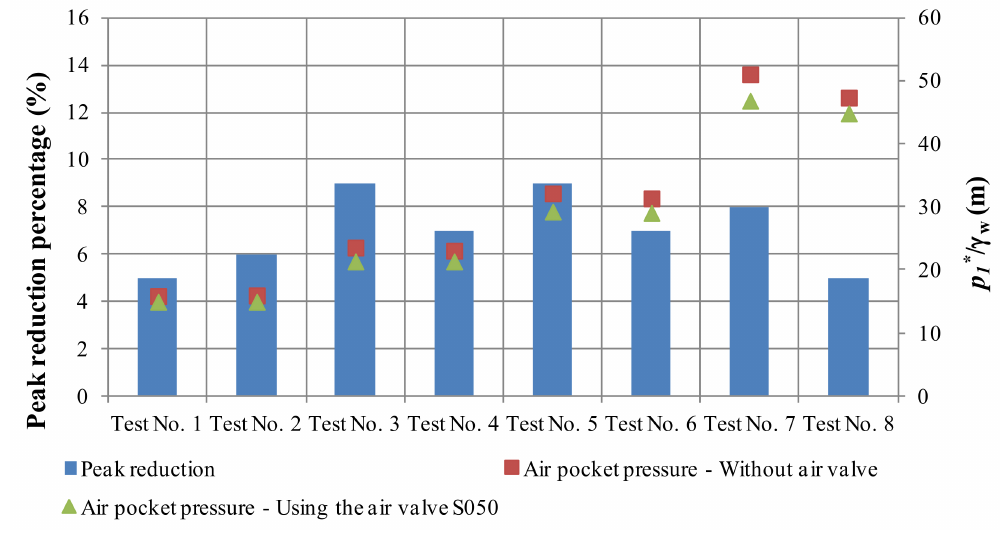
Figure 7. Peak reduction percentage vs. maximum air pocket pressure attained. Table 3. Summary of extreme values of reached pressure